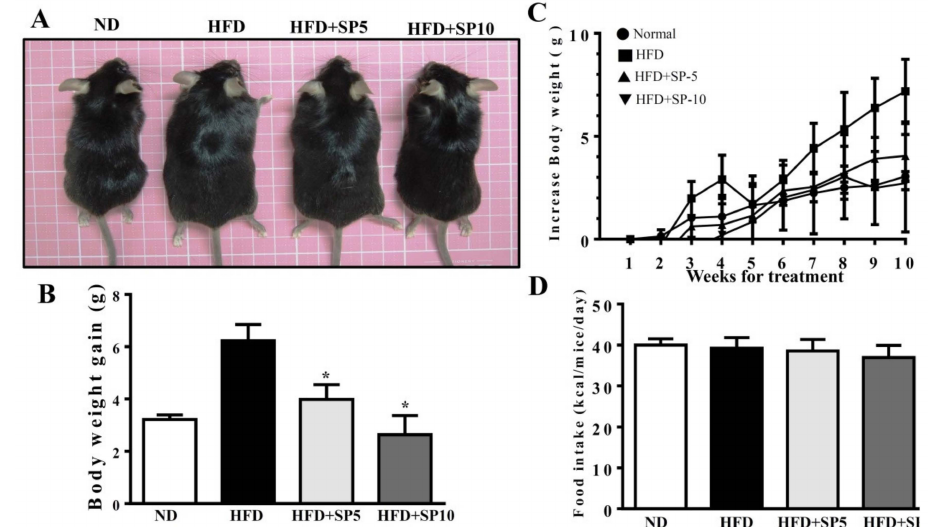
Figure 5. Spilanthol (SP) ameliorates adiposity and decreases body weight gain in high-fat diet (HFD)-induced obese mice. ( A ) Representative images of the whole body. ( B ) Body weight (BW) and ( C ) body weight gain. ( D ) Food intake (kcal / mice / day). C57BL / 6 mice were fed a normal diet (ND) or high-fat diet (HFD) with or without a low dose of SP (5 mg spilanthol / kg BW; SP5) or high dose of SP (10 mg spilanthol / kg BW; SP10) for eight weeks. The data are presented as means ± SD, n = 8; * p < 0.05 compared to HFD-fed mice alone.